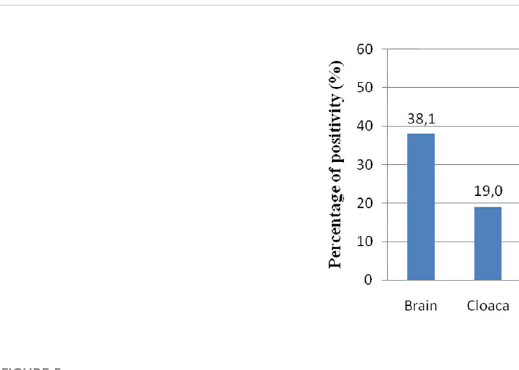
FIGURE 5 Prevalence of ChHV5 in the different organs analysed. The spleen is not considered since only three samples were